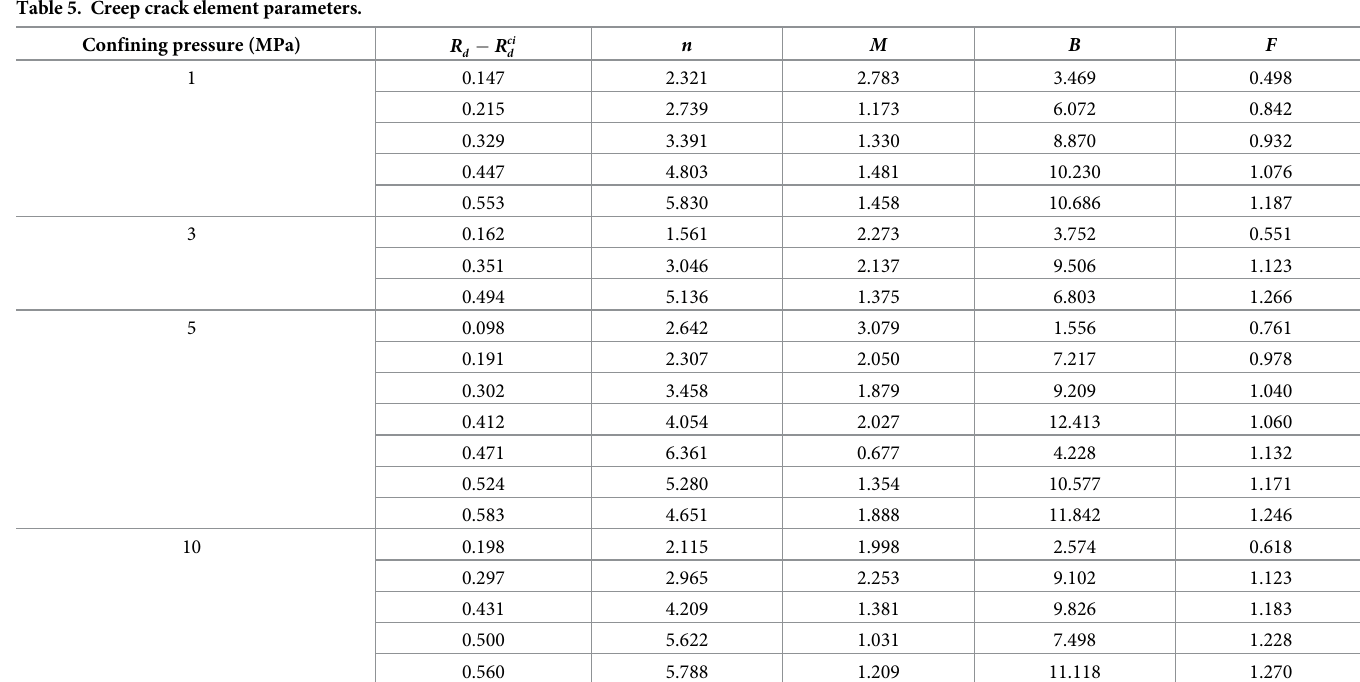
Table 5. Creep crack element parameters. Confining pressure